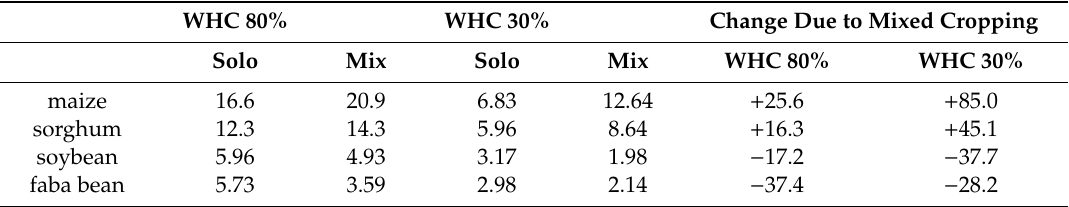
Table A5. Biomass of one individual plant in the Water-Trial.